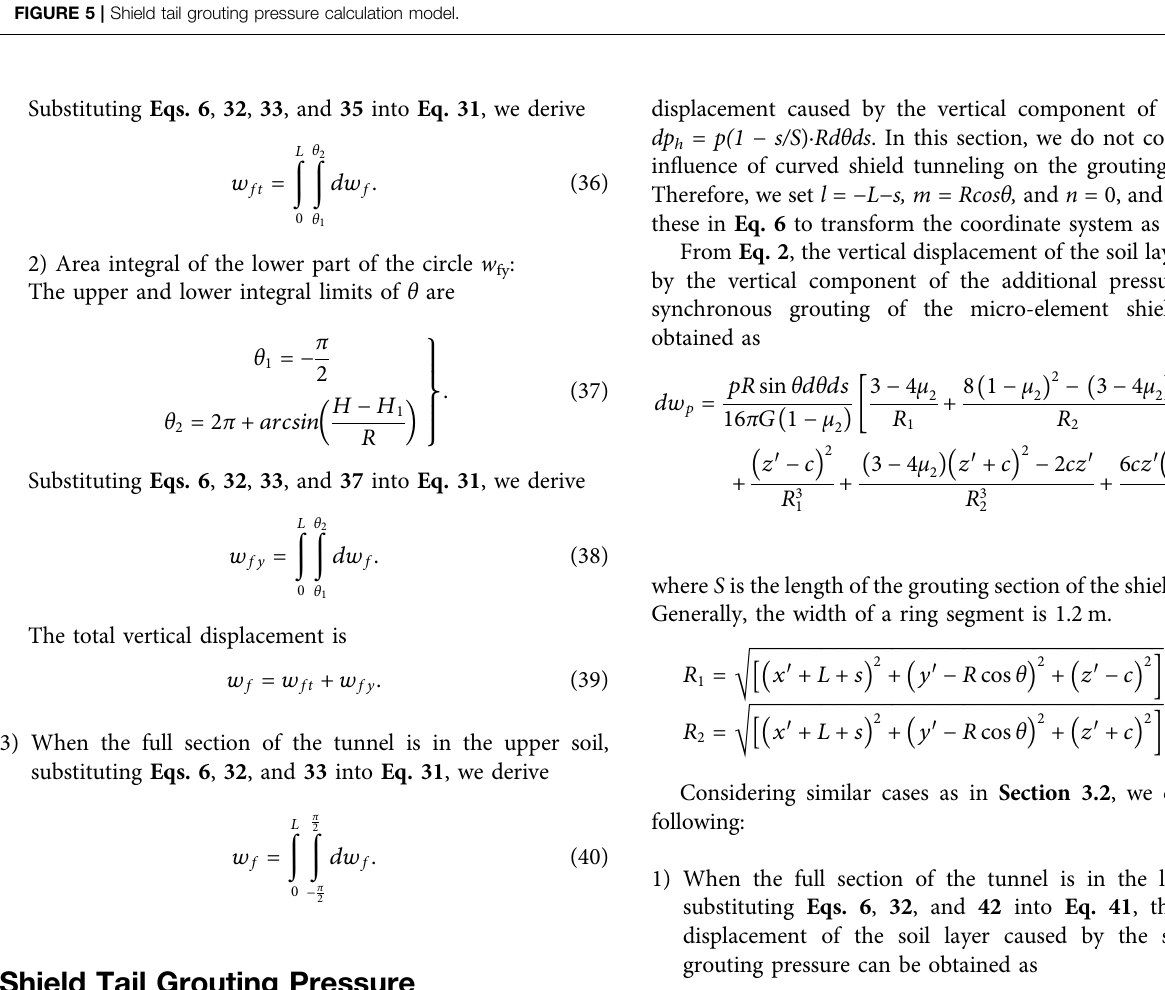
FIGURE 5 | Shield tail grouting pressure calculation